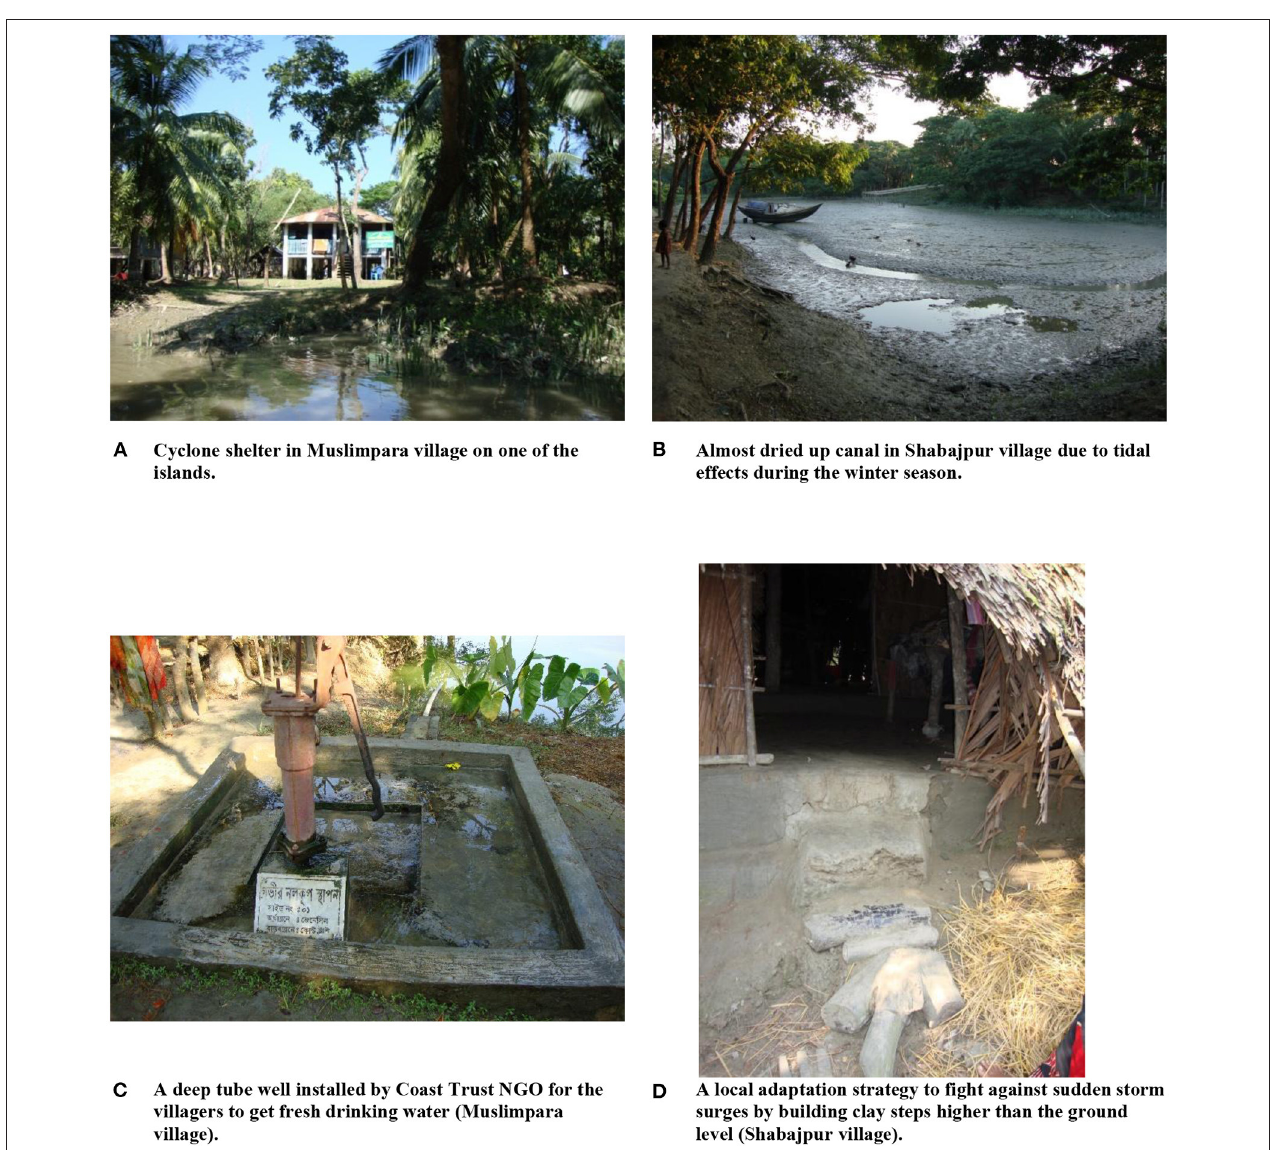
FIGURE 5 | (A–D) Local policy beneficiary level: Char Kukri Mukri Union, Char Fasson Sub-District of Bhola District. November 2011 (Photographs by